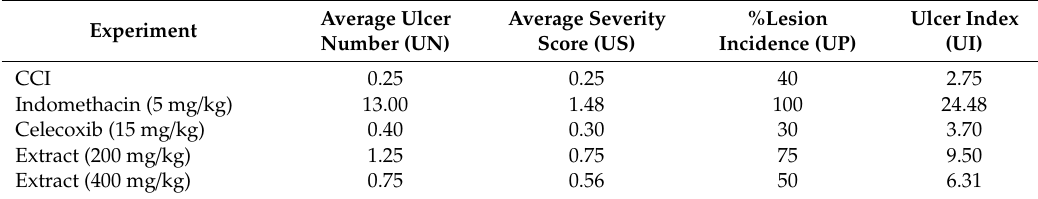
Table 4. Chronic ulcerogenecity testing of H. campechianum flower extract along with two reference drugs, celecoxib and